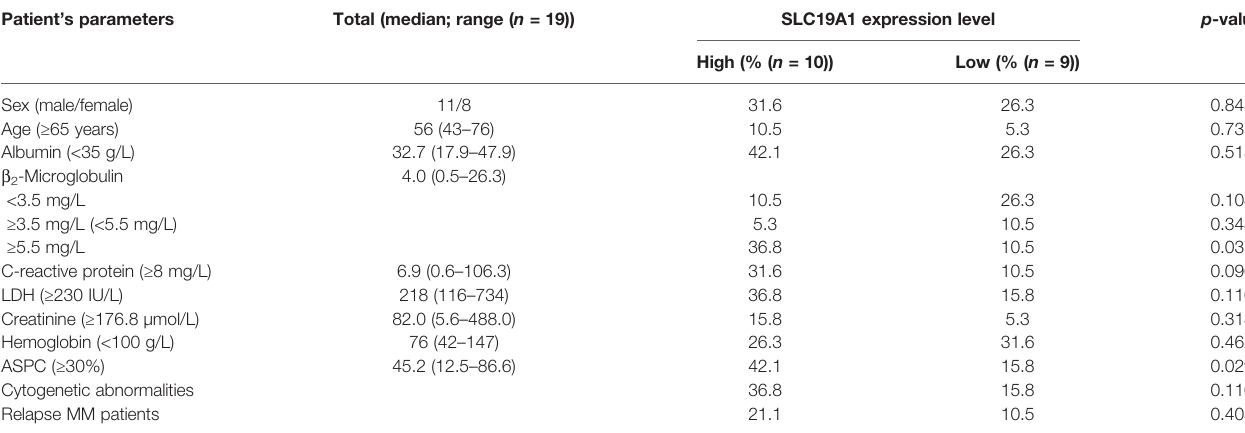
TABLE 4 | Correlation of SLC19A1 expression with clinical and laboratorial parameters in MM patients. Patient ’ s